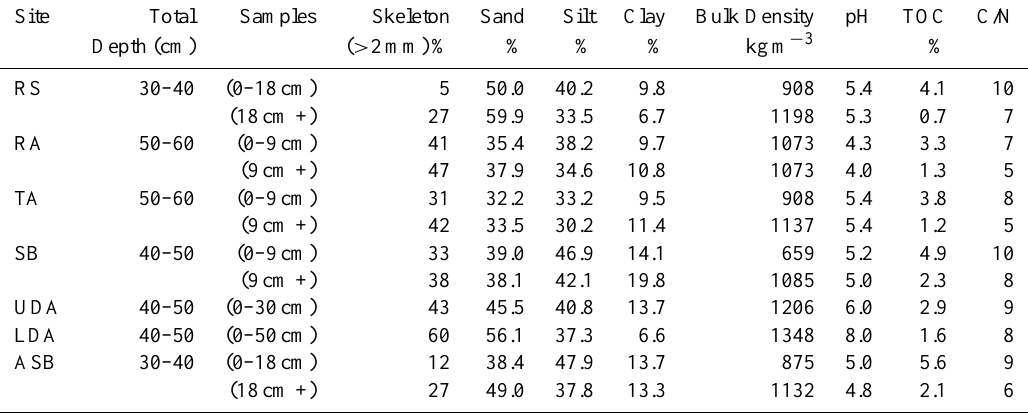
Table 2. Main physico-chemical characteristics of the investigated soils (average values). Site Total